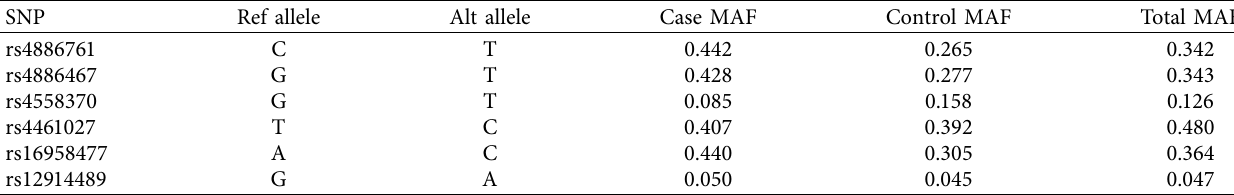
Table 3: The MAF of these SNPs.